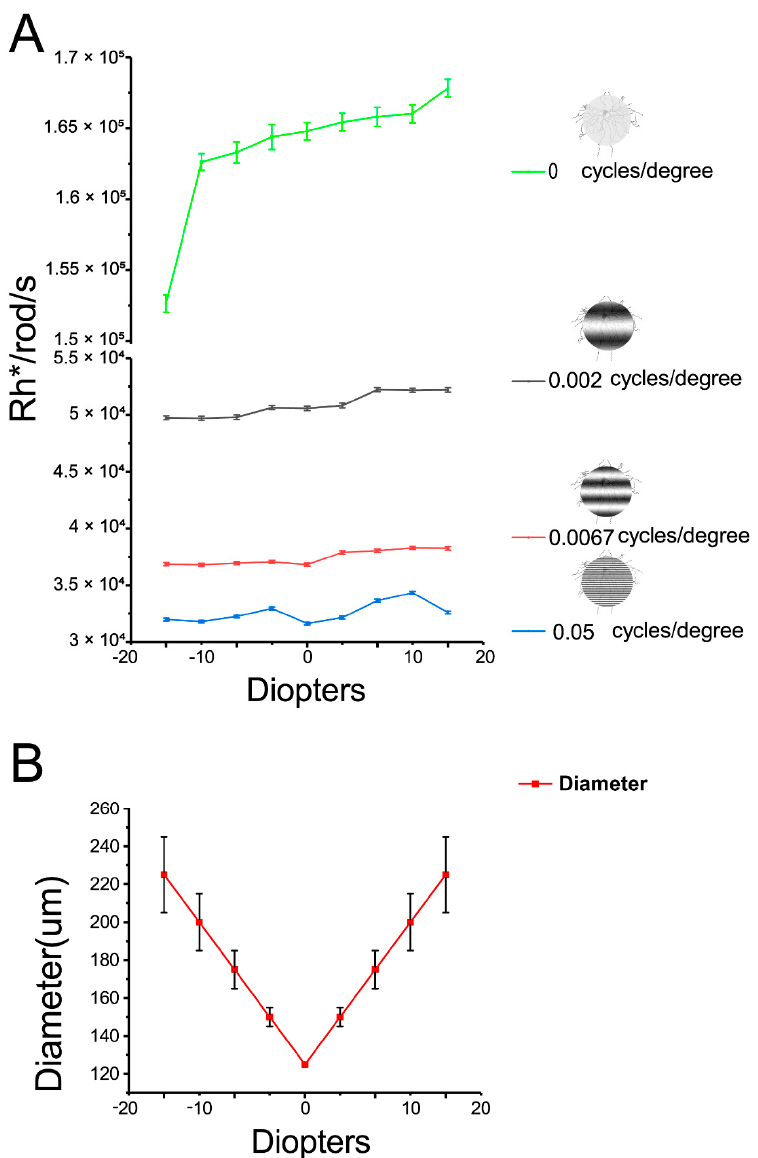
Figure 2. Variance of light intensities and light spot area with defocused image. A : Defocused images of a 125 µ m 0 cycles / degree from -20 to + 20 diopters increased the light intensities from 1.53 × 10 5 Rh* / rod / sec to 1.69 × 10 5 Rh* / rod / sec. Increasing spatial frequencies will decrease light intensities. Defocused di ff erent spatial frequencies images from − 20 to + 20 diopters increased light intensities slightly. Defocused images of a 125 µ m 0.002 cycles / degree from − 20 to + 20 diopters changed the light intensities from 4.99 × 10 4 Rh* / rod / sec to 5.25 × 10 4 Rh* / rod / sec; 0.0067 cycles / degree from 3.74 × 10 4 Rh* / rod / sec to 3.85 × 10 4 Rh* / rod / sec; 0.05 cycles / degree from 3.2 × 10 4 Rh* / rod / sec to 3.46 × 10 4 Rh* / rod / sec. B : Increasing the diopters of defocused images of a 125 µ m light spot results in a linear increase in the diameter of image projected on the RGC layer. With increasing defocused distance, the edge of the image became hard to define, especially with the + 20 and − 20 diopters defocused images